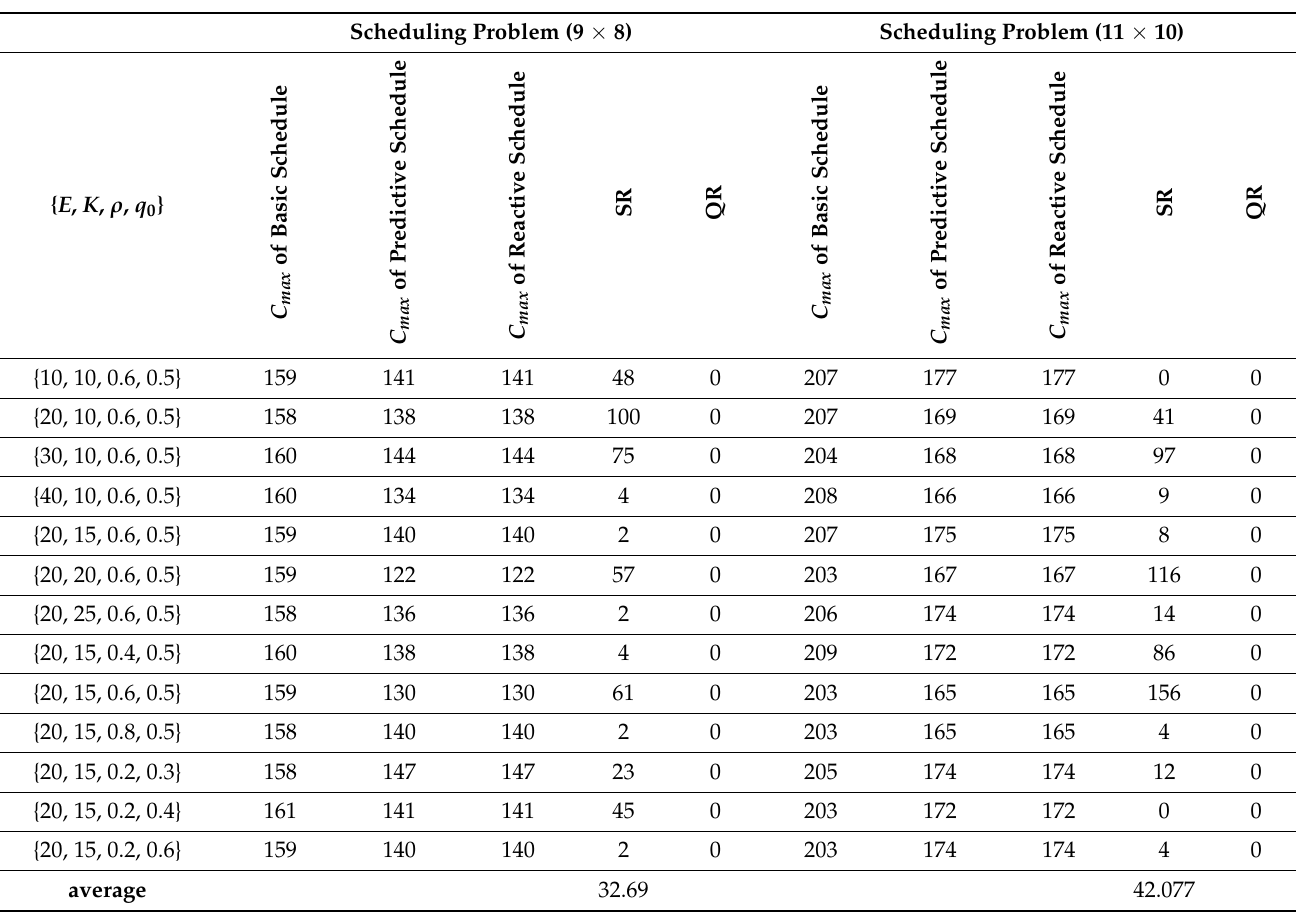
using the MIDOS I was C max (1) = 141. The makespan function of the reactive schedule generated using the MIROS was also C max (1*) = 141. The solution robustness was SR(1) = 48 and the quality robustness was QR(1) = 0 for the first scheduling problem (9 × 8). Quality of the task sequences achieved for the remaining ants for scheduling problems (9 × 8) and (11 × 10) is described in Table 1. Also, computer simulations were run for generating predictive schedules using the MIDOS II. Quality of the predictive and reactive schedules for scheduling problems (9 × 8) and (11 × 10) is described in Table 2. The average solution robustness of predictive schedules generated using the ACO and MIDOS I was 32.69 for scheduling problem (9 × 8) and 42.07 for scheduling problem (11 × 10) (Table 1). The average solution robustness of predictive schedules generated using the ACO and MIDOS II was 31.92 for scheduling problem (9 × 8) and 27.46 for scheduling problem (11 × 10) (Table 2). All achieved schedules are robust taking into account the quality robustness criterion for both scheduling problems (9 × 8) (Table 1) and (11 × 10) (Table 2). By analyzing the minimum, maximum, first quantile, third quantile and the mean values of solution and quality robustness, the following conclusion can be drawn: the MIDOS II heuristic is better to apply to the basic schedules generated by ACO (Figure 7). Table 1. The schedules generated using the MIDOS I and MIROS for the best basic schedules achieved by the ACO and input parameters { ρ , K , E , q 0